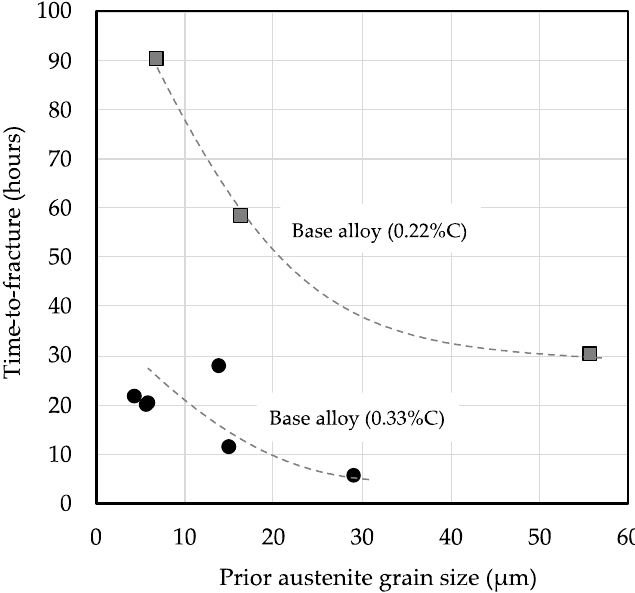
Figure 10. Influence of the PAGS in the base alloy on the delayed fracture resistance in 2000 (0.33%C) and 1500 MPa (0.22%C) press hardening steels after bake hardening treatment.